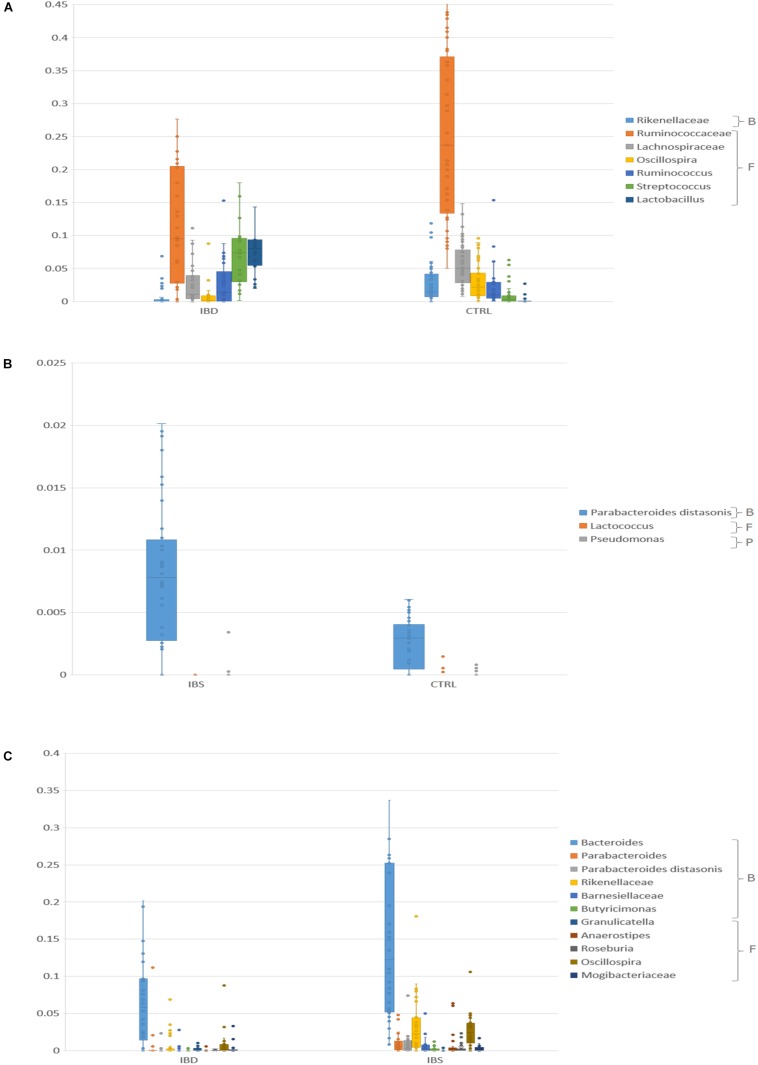
Bar chart reporting Kruskal-Wallis test results on OTUs grouped at taxonomic level of families/species for IBD vs. CTRL (A), IBS vs. CTRL (B), and IBD vs. IBS (C), in fecal samples. Fecal samples have been grouped and averaged in the comparisons. For the IBD vs. CTRL (A) comparison, only OTUs that showed pFDR < 0.05 and relative abundance >0.01 were reported. For the IBS vs. CTRL (B) only OTUs that showed p < 0.05 were reported. For the IBD vs. IBS (C) comparison, only OTUs that showed pFDR < 0.05 were reported. B, Bacteroidetes, F, Firmicutes, P, Proteobacteria.